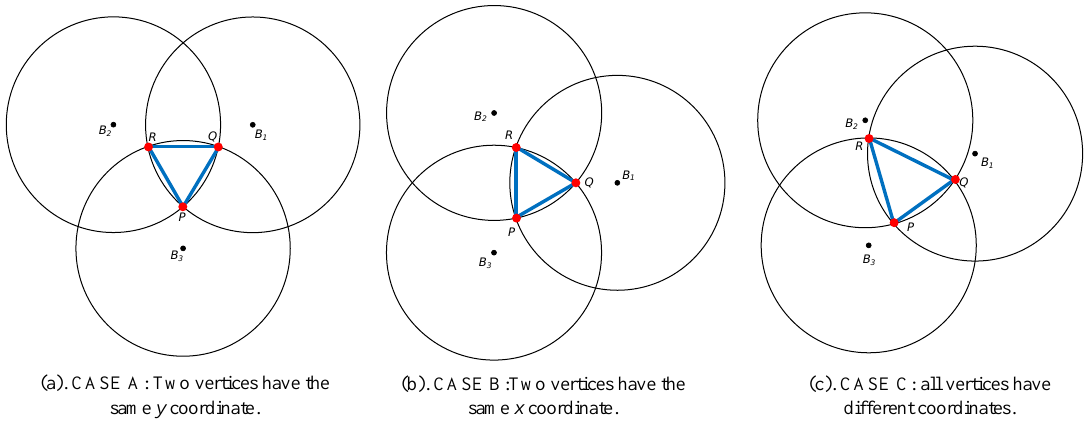
Figure 7. Cases of  PQR vertices